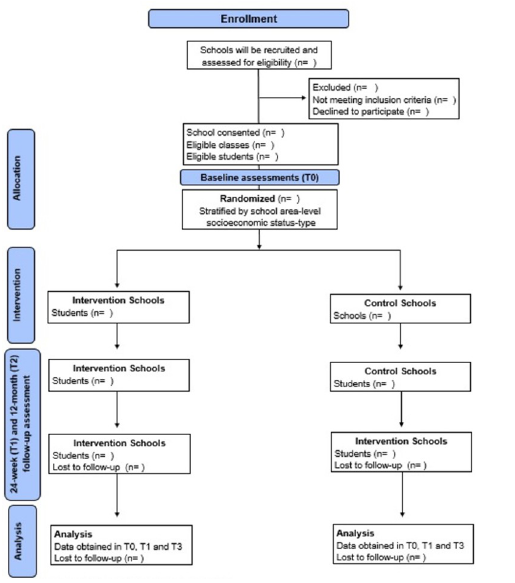
Fig 1. Protocol timeline implemented for the